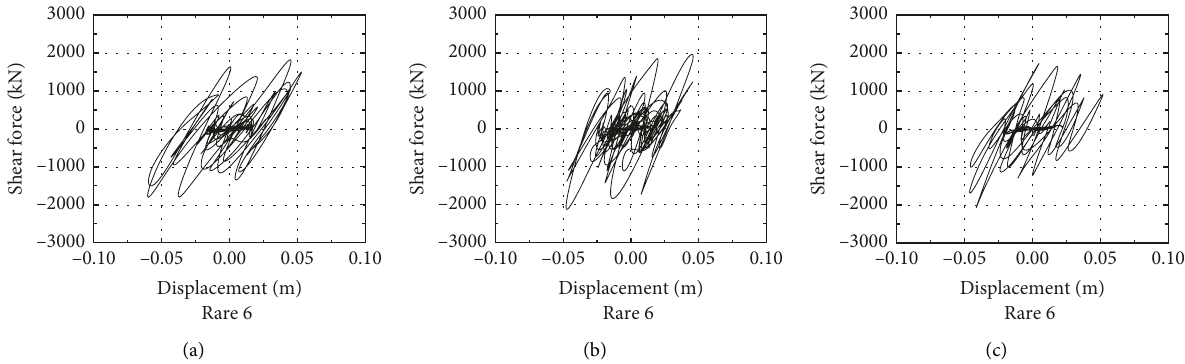
Figure 9: Hysteresis curve of the prototype structure under different waves: (a) El Centro wave; (b) Taft wave; (c) artificial seismic